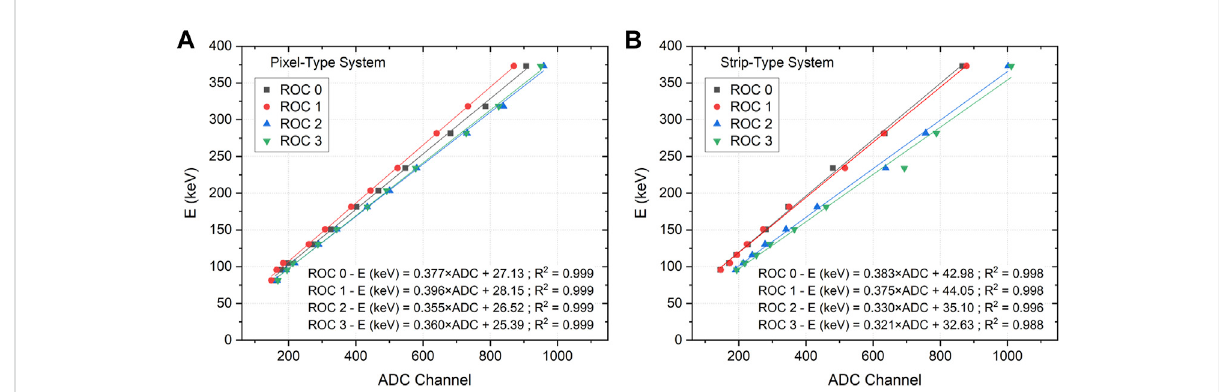
FIGURE 4 Energy calibration obtained for each ROC in (A) the pixel system and (B) the strip system. The deposited energies calculated with SRIM simulations were fi tted to the experimental ADC channels with a linear model.